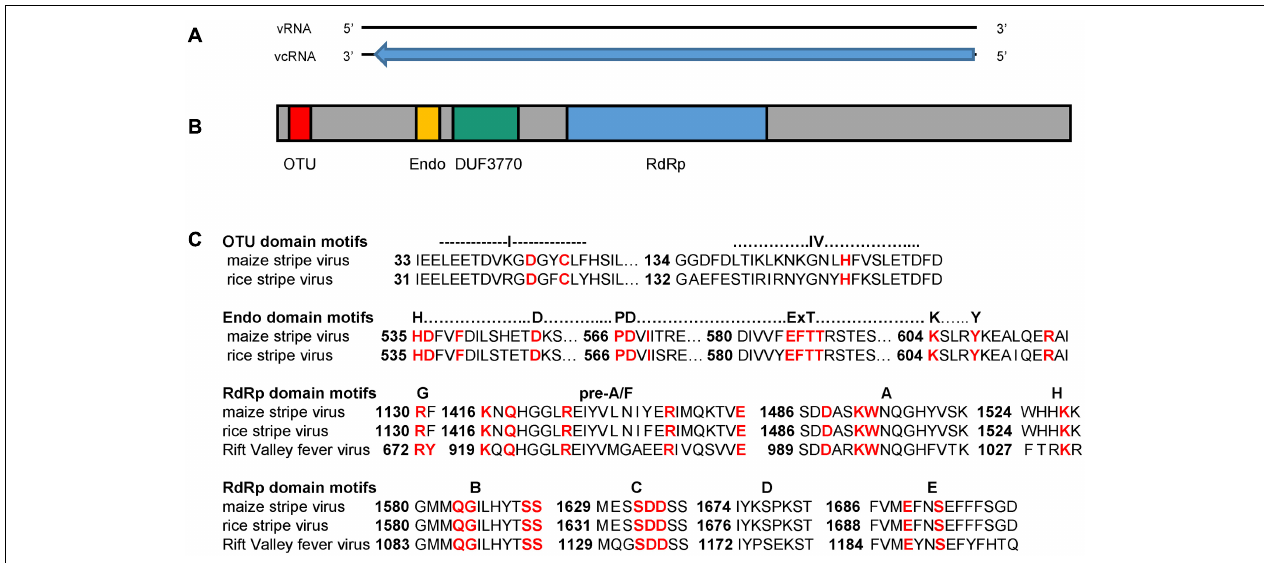
FIGURE 1 | (A) Schematic diagram of MSpV21 vcRNA1 at 9,011 nt in length (black bar) with contiguous coding region for pc1 covering nucleotide positions 50–8809 (blue arrow). (B) Schematic diagram of MSpV21 pc1 amino acid sequence with conserved domains (colored boxes) identified by the National Center for Biotechnology Information (NCBI) Conserved Domain Search tool (Lu S. et al., 2019) indicated. OTU = Ovarian tumor-like cysteine protease (Accession cl19932/E-value 6.03e-03) (amino acid positions 42-123); Endo = N-terminus bunyavirus endonuclease (Accession cl20011/E-value 2.76e-07) (amino acid positions 512-599); DUF3770 = domain of unknown function found in viruses (Accession cl13978/E-value 9.60e-57) (amino acid positions 648-889); RdRp = Bunyavirus RNA-dependent RNA polymerase (Accession = cl20265/E-value = 0e + 00) (amino acid positions 1,066–1,802) (C) Alignment between pc1 sequences of maize stripe virus isolate MSV21 and rice stripe virus (NCBI Reference Sequence NP_620522.1) with focus on the domain regions with conserved and/or essential amino acids marked in red. The RdRp sequence for the phlebovirus Rift Valley fever virus (NCBI Accession ACE78348.1) was also included in the RdRp domain motif analyses.